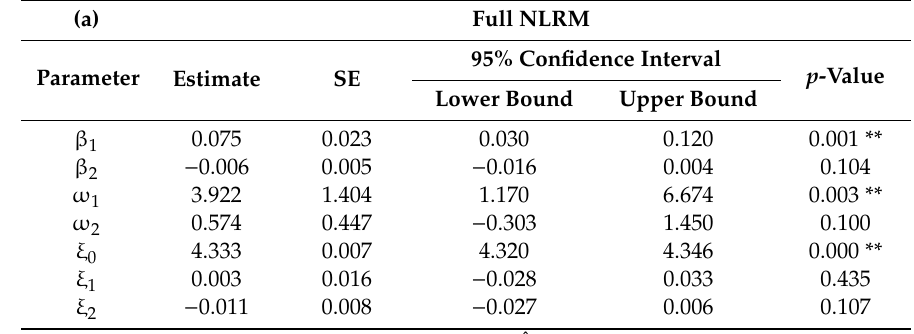
Table 2. Estimated fixed e ff ect parameters in the full non-linear regression model (NLRM) ( a ) and those in the optimal NLRM ( b